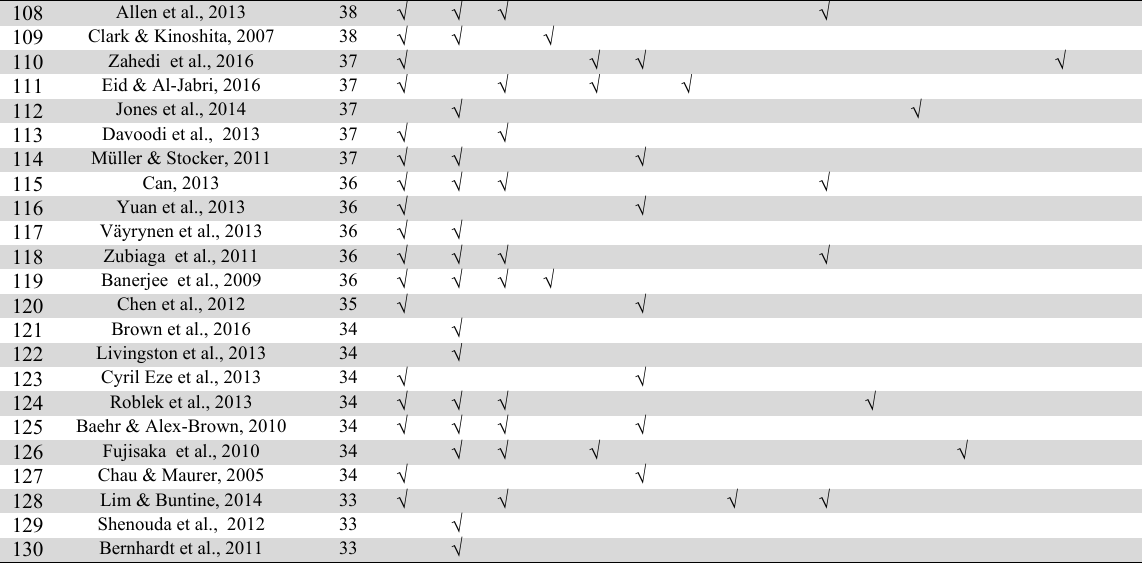
Table 2 demonstrates some of the most popular keywords used in the studies associated with knowledge management. As observed from the results of Table 1, “knowledge management” and “Social media” and “social networking”, are three keywords known in the literature. The most popular keywords used in studies associated with knowledge management and social media